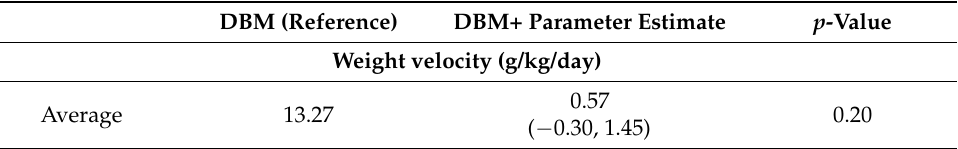
Table 8. Linear model of growth velocity comparisons between DBM and DBM+ groups, adjusted for